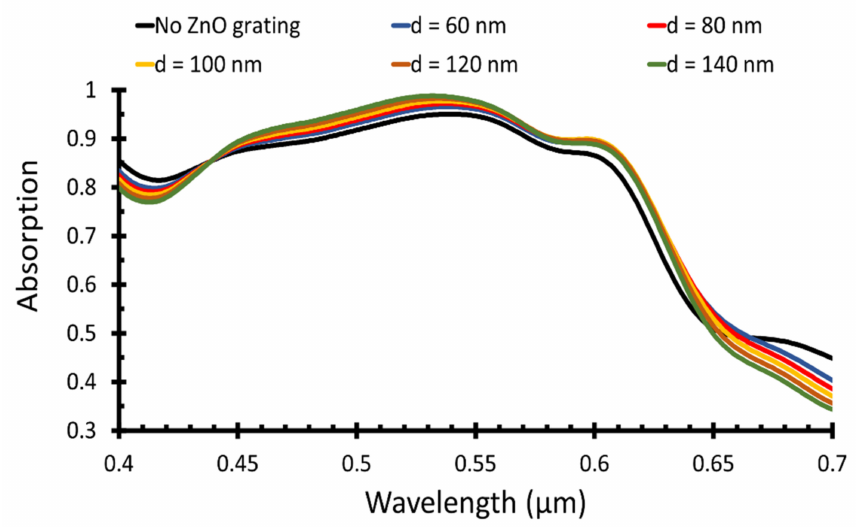
Figure 2. Absorption of different ZnO grating periods versus optical